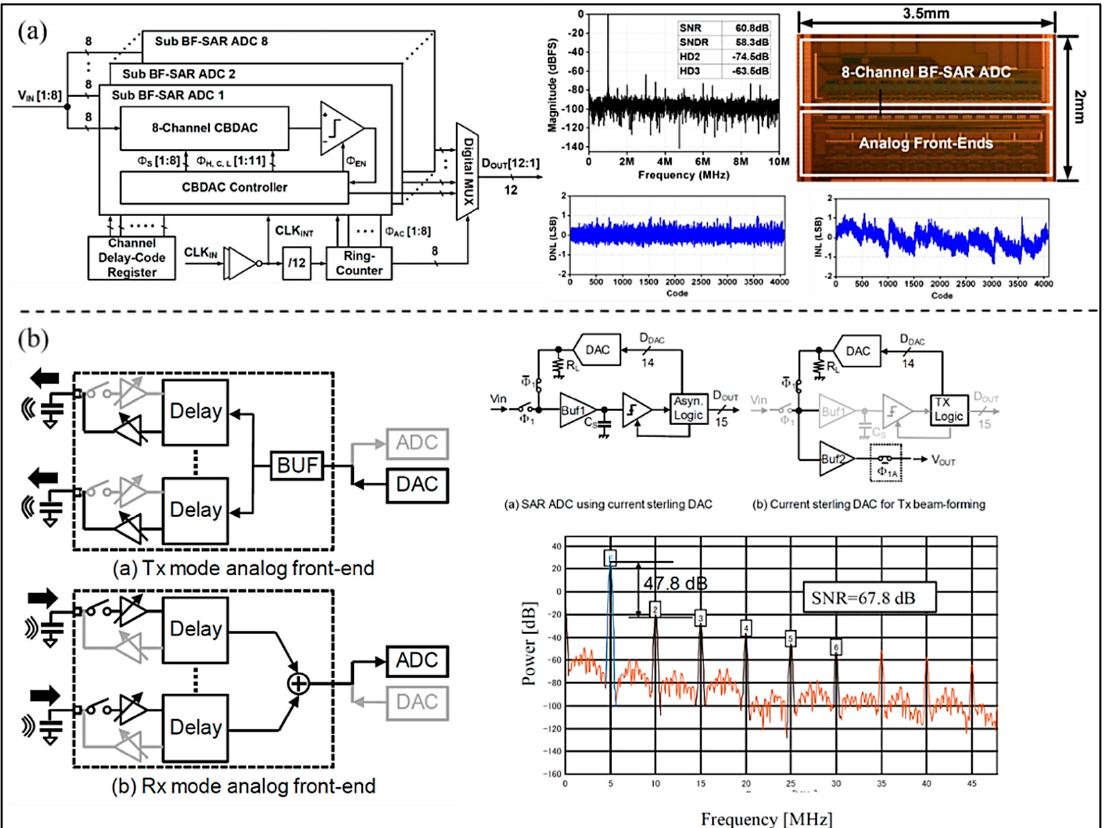
Figure 7. ( a ) Block diagram, die micrograph, and measured results of the proposed SAR ADC. (Re- printed from [45], Copyright 2017, with permission from IEEE); ( b ) Structure diagram and measured results of SAR ADC. (Reprinted from [46], Copyright 2018, with permission from IEEE).